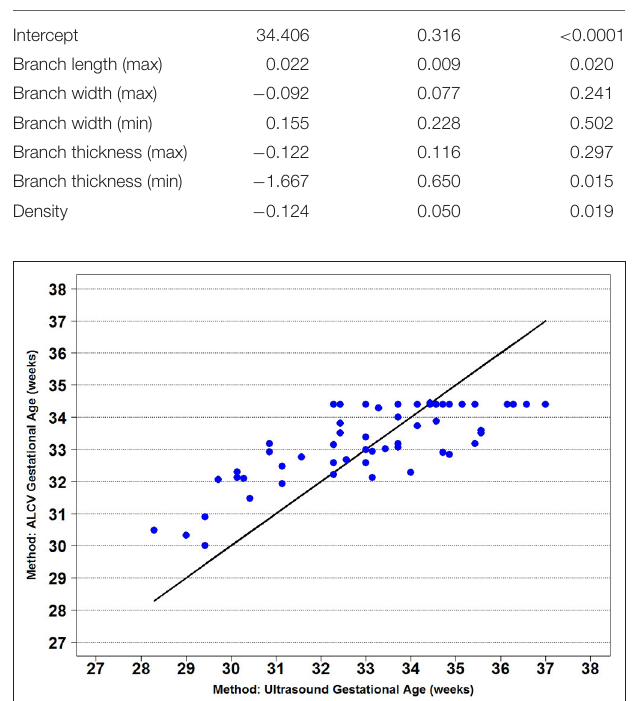
FIGURE 2 | Identity plot of anterior lens capsule vascularity (ALCV) gestational age against ultrasound gestational age.